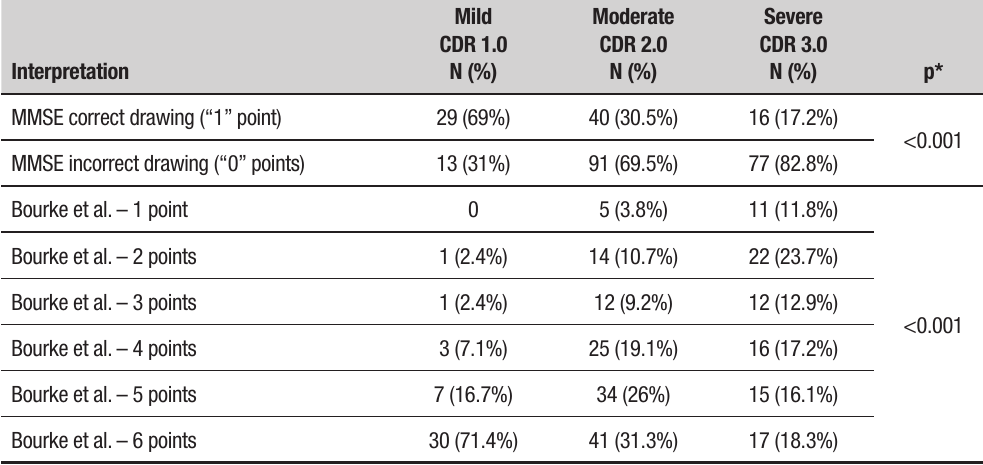
Table 2. Analysis of the PDT by MMSE binary method and Bourke et al. according to dementia stage.